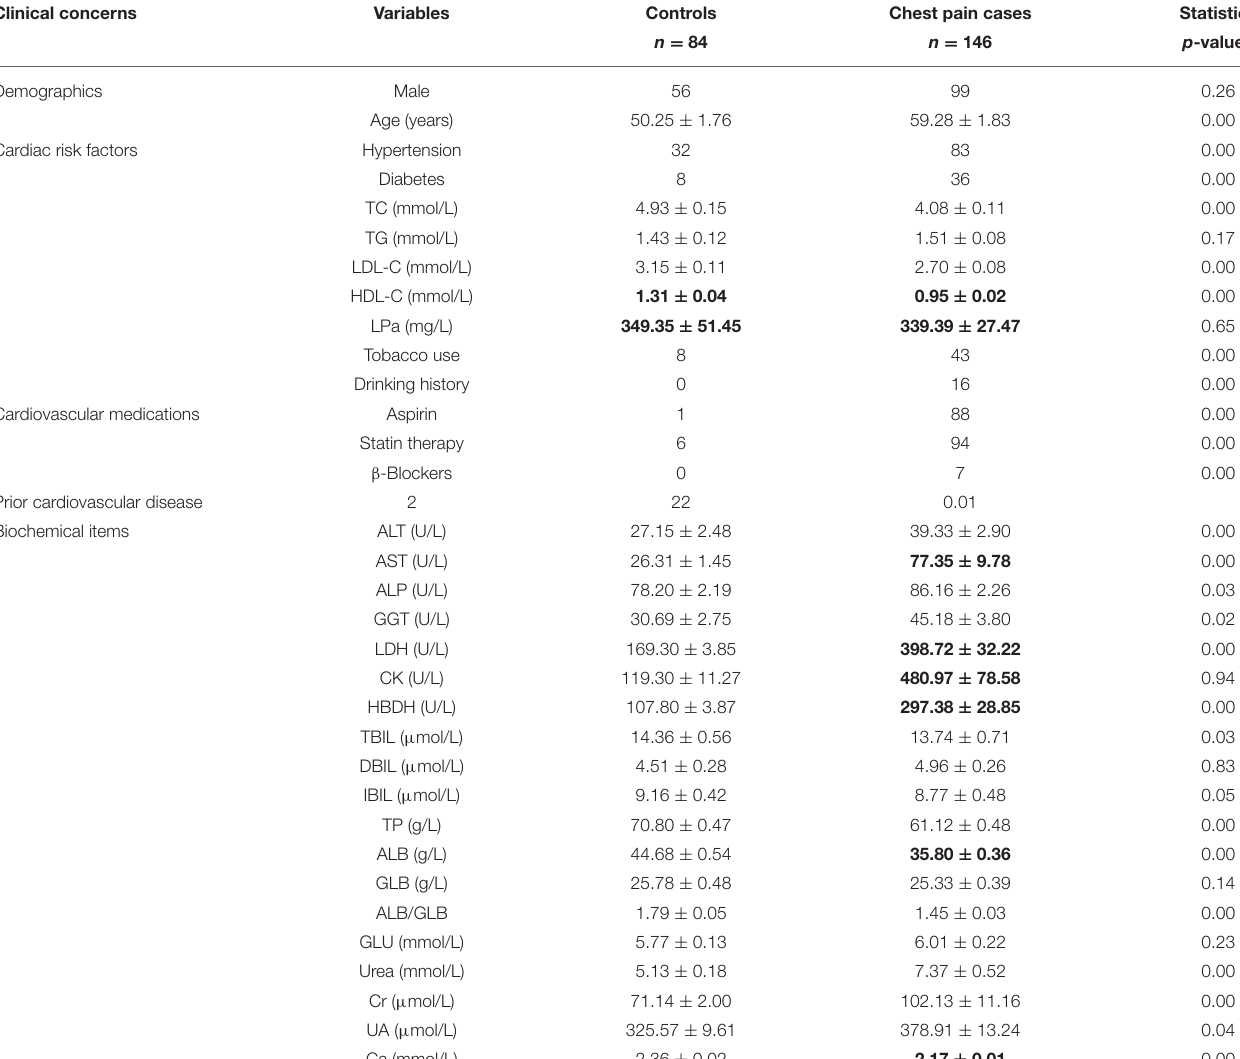
TABLE 1 | Sample characteristics: controls vs. all the chest pain